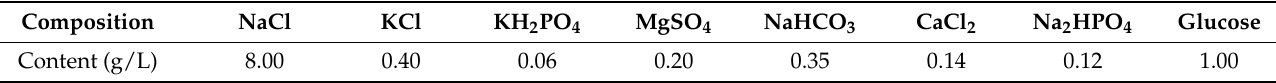
Table 2. Chemical composition of Hank’s solution